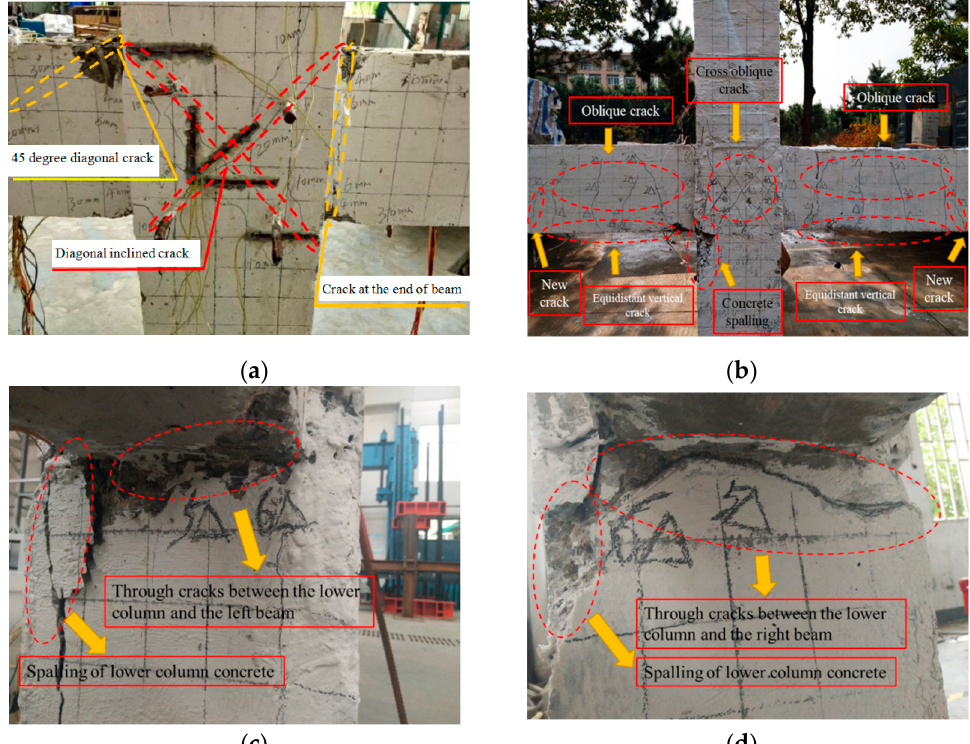
Figure 4. Failure modes of specimens: ( a ) Failure characteristics of ZJ0; ( b ) Failure characteristics of ZJ2; ( c ) Through cracks on the left beam and lower column of ZJ2; ( d ) Through cracks on the right beam and lower column of ZJ2.